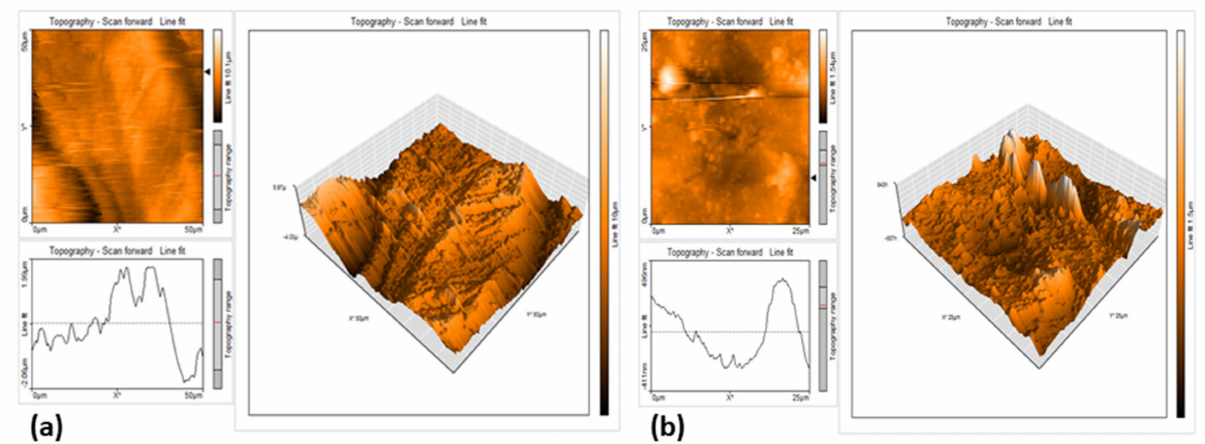
Figure 9. ( a ). AFM cross sectional images of the polished mild steel surface and ( b ) AFM cross sectional images of the mild steel surface after immersion in 1.0 M HCl.